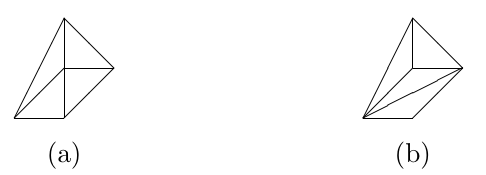
Figure 1 . Two triangulations of the 2D face corresponding to the base resulting from distinct Calabi-Yau phase triangulations of the 4D polytope associated with the generic elliptic (cid:12)bration over the Hirzebruch surface F 1 ; the (cid:12)rst triangulation gives a toric variety with a toric morphism to the base F 1 , while the second triangulation gives a variety with a non-(cid:13)at toric morphism to P 2